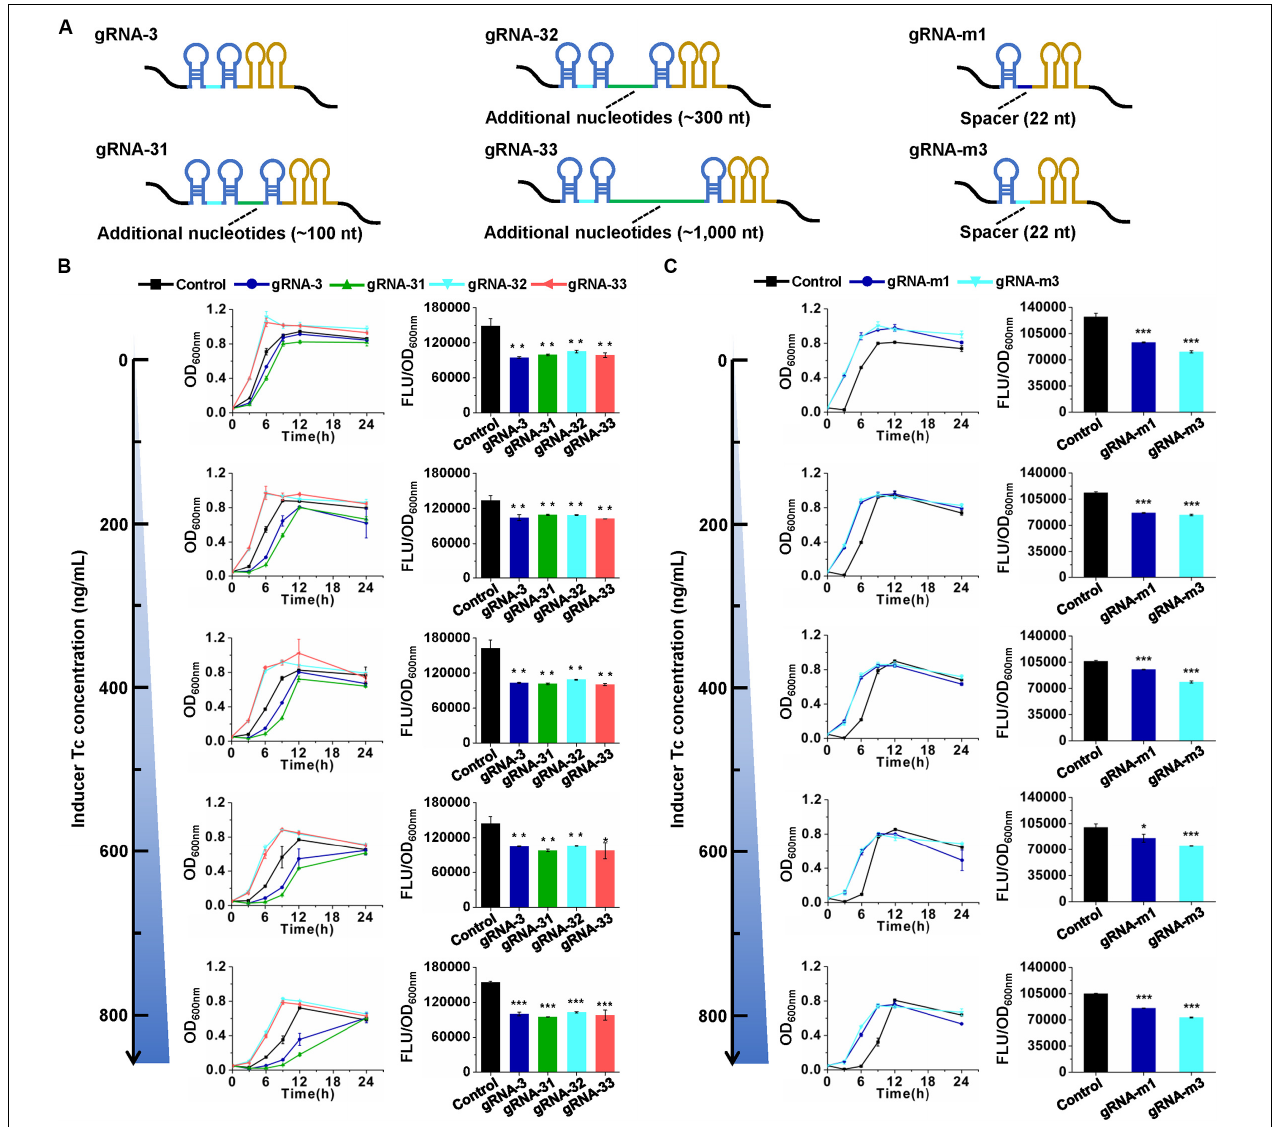
FIGURE 4 | Effects of gRNA architecture on gene repression efficiency. (A) Architectures of pre-gRNAs containing 30-nt spacers and additional nucleotides and mature gRNAs containing 22-nt spacers. gRNA-31, gRNA-32, and gRNA-33 have the same spacer with gRNA-3 but additional nucleotides downstream of the second DR. gRNA-m1 and gRNA-m3 have 22-nt spacers, which are the same with the CasRx-processed gRNA-1 and gRNA-3, respectively. The spacer sequences are listed in Supplementary Table S3 . (B) Growth and GFP fluorescence with pre-gRNAs and inducer at different concentrations. (C) Growth and GFP fluorescence with mature gRNAs and inducer at different concentrations. pCasRx-3 and different gRNA expression plasmids were co-transformed into E. coli harboring pGFP for gene repression. Inducer was added at the beginning of cultivation to induce casRx expression. GFP fluorescence and OD 600 nm were determined after 24 h cultivation. Error bars indicate standard deviations from three parallel experiments. All t -tests compare the GFP fluorescence per OD 600 nm using gfp -targeting gRNAs against non-targeting gRNA control (* P < 0.05, ** P < 0.01, *** P <